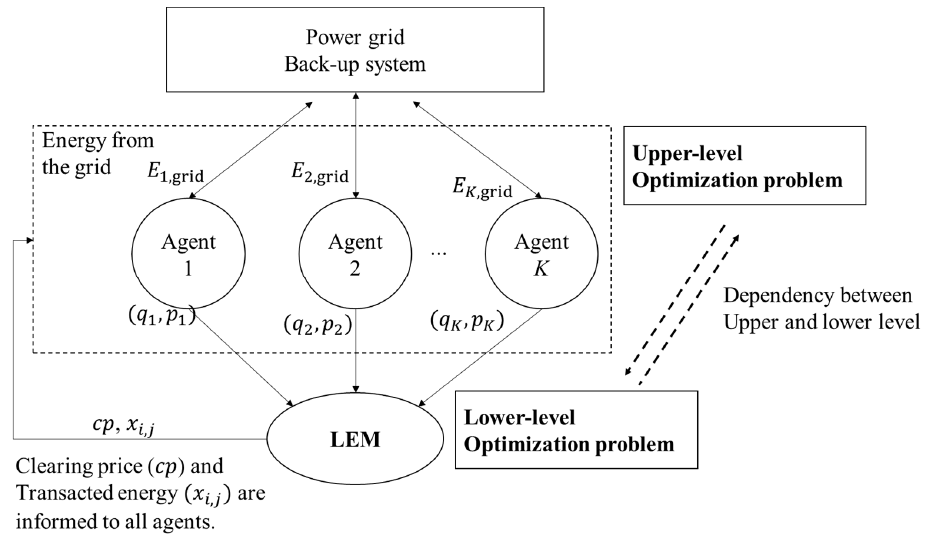
Figure 2. LEM and the main grid as back-up system [15].